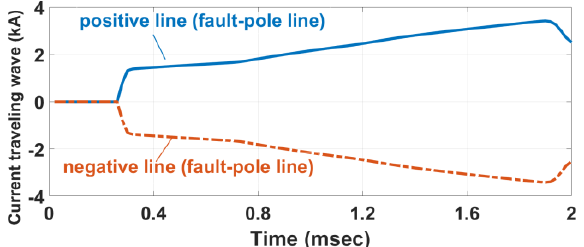
Figure 6. Diagram of the bipolar short-circuit